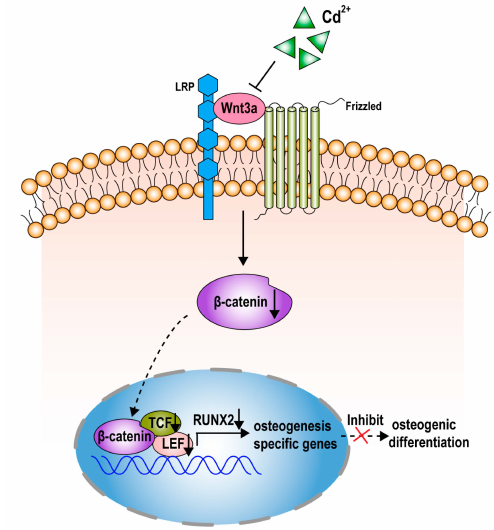
Figure 7. A schematic representation shows the proposed mechanism. The Wnt/ β -catenin pathway is involved in the suppression of osteoblast differentiation of BMMSCs induced by CdCl 2 . A schematic representation of the proposed pathway for Wnt/ β -catenin, which is inhibited by CdCl 2 , resulting in transcriptional reduction of Runx2 and the poor osteoblast differentiation of